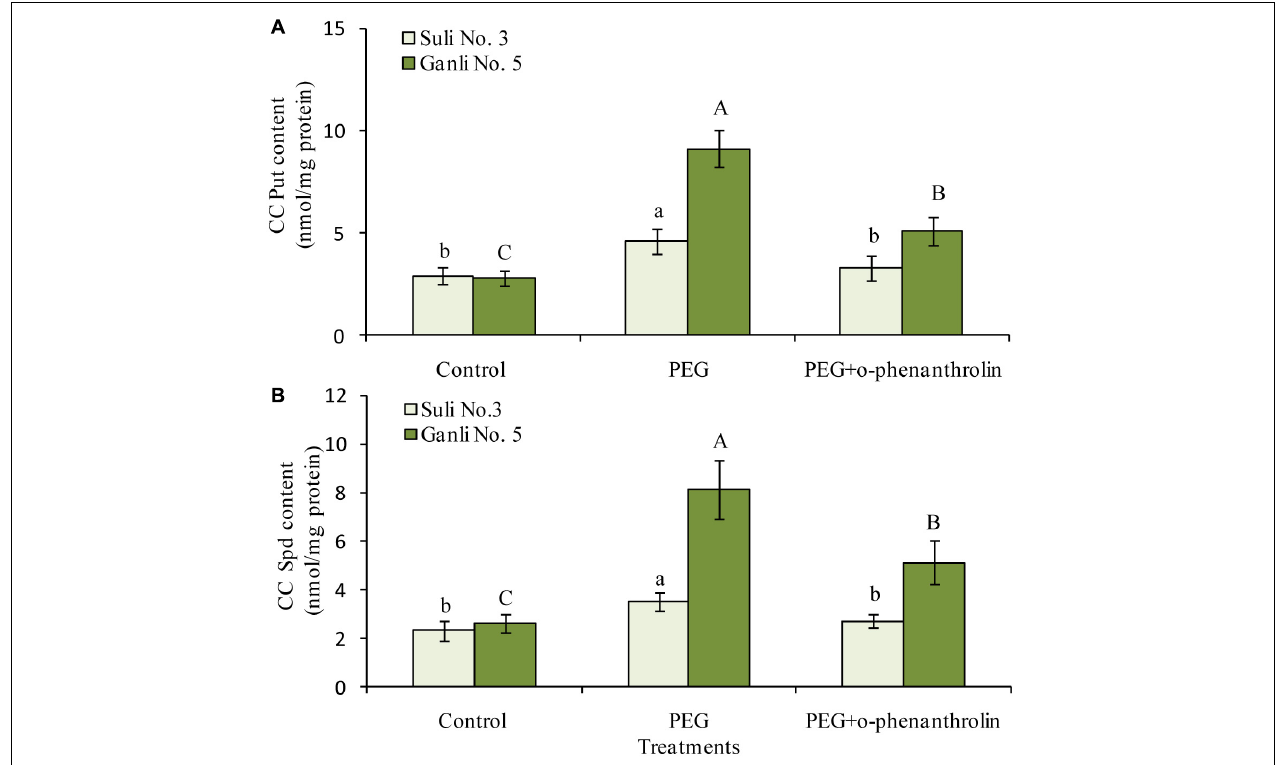
FIGURE 6 | Changes in the contents of CC Put (A) and CC Spd (B) in the plasma membrane of plum seedling roots under PEG and o-phenanthroline. Control: treatment without PEG or the other reagents (–0.15 MPa); PEG: treatment with PEG (–0.85 MPa); PEG + o-phenanthroline: treatment with PEG and o-phenanthroline (0.2 mM). The data here were means ( n = 9) ± standard error of 3 independent experiments. Significant differences between treatments are indicated with letters, with upper and lower letters for each cultivar ( P <